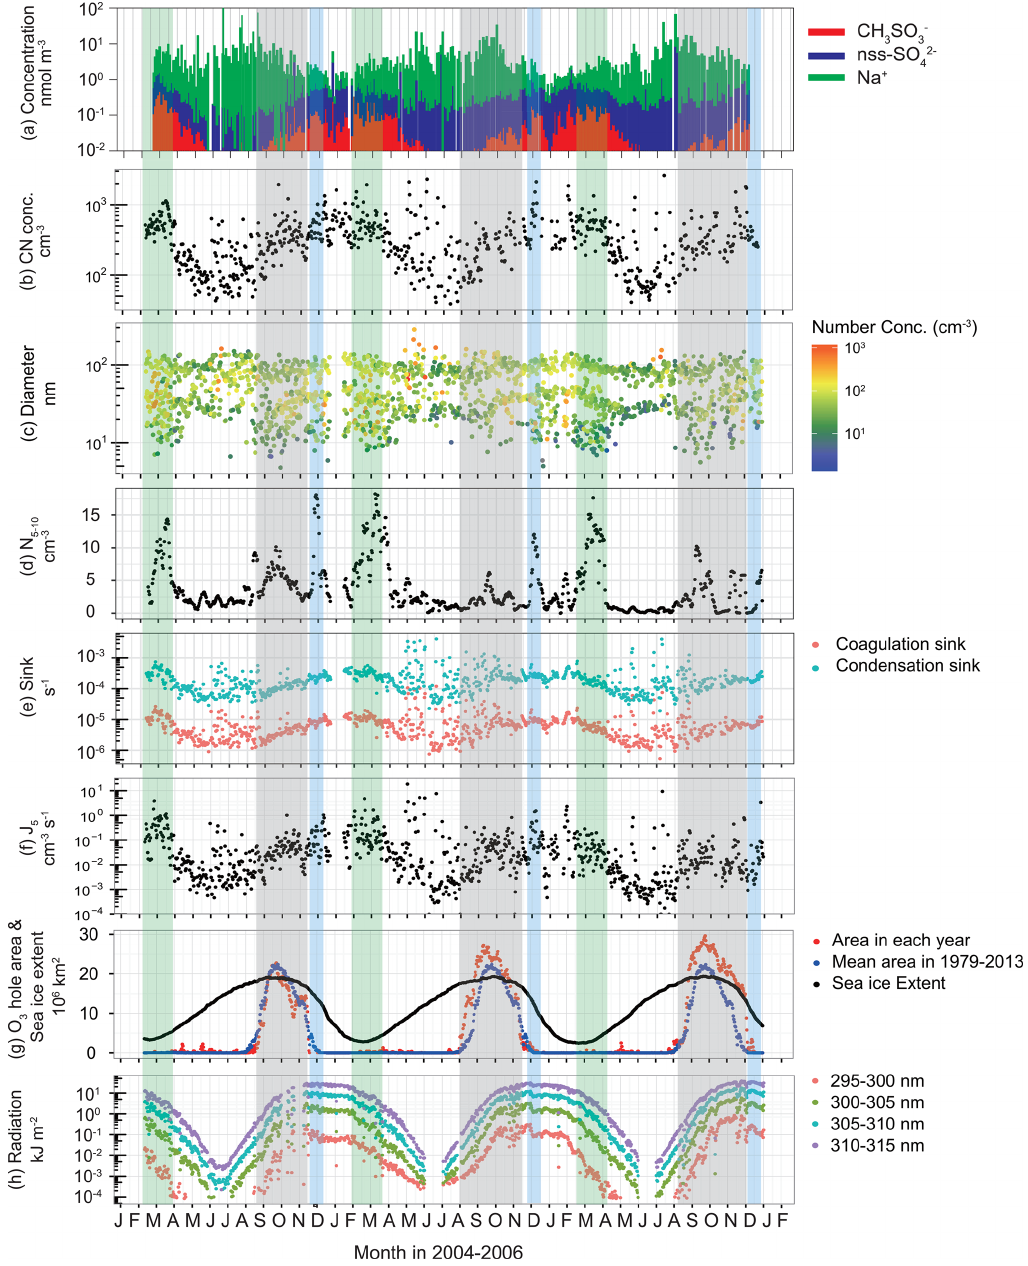
Figure 7. Seasonal variations of (a) the concentrations of CH 3 SO 3 − , non-sea-salt (nss) SO 42 − and Na + in D p < 200nm, (b) CN con- centrations ( D p > 10nm), (c) modal sizes and number concentrations in each mode, (d) 30d running mean aerosol number concentrations of fresh-nucleation mode ( D p = 5–10nm), (e) coagulation sink of aerosol particles ( D p = 5nm) and condensation sink, (f) nucleation rate of aerosol particles with D p = 5nm ( J 5 ), (g) extent of the Antarctic ozone hole, and (h) UV radiation near the surface at Syowa Station, Antarctica, during January 2004–December 2006. Green-shaded, grey-shaded and blue-shaded bands, respectively, represent periods of the minimum of sea-ice extent and high CH 3 SO 3 − concentrations, ozone hole appearance and summer solstice. Concentrations of nss-SO 2 − were calculated using Na + concentrations and molar ratios in seawater (SO 42 − / Na + = 0 . 0602; Millero et al., 2008) during November– March and ratios in sea salts (SO 42 − / Na + = 0 . 01; Hara et al., 2012, 2018) in April–October because the SO 42 − / Na + ratio is changed by sea-salt fractionation on sea ice during April–October (Hara et al., 2012, 2018). The ozone hole extent and sea-ice extent data were provided, respectively, by NASA (https://ozonewatch.gsfc.nasa.gov/, last access: 6 August 2021) and the National Snow and Ice Data